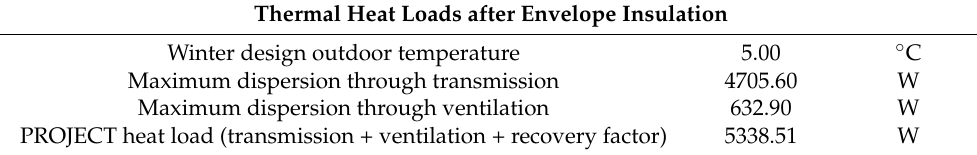
Table 17. Thermal heat loads after envelope